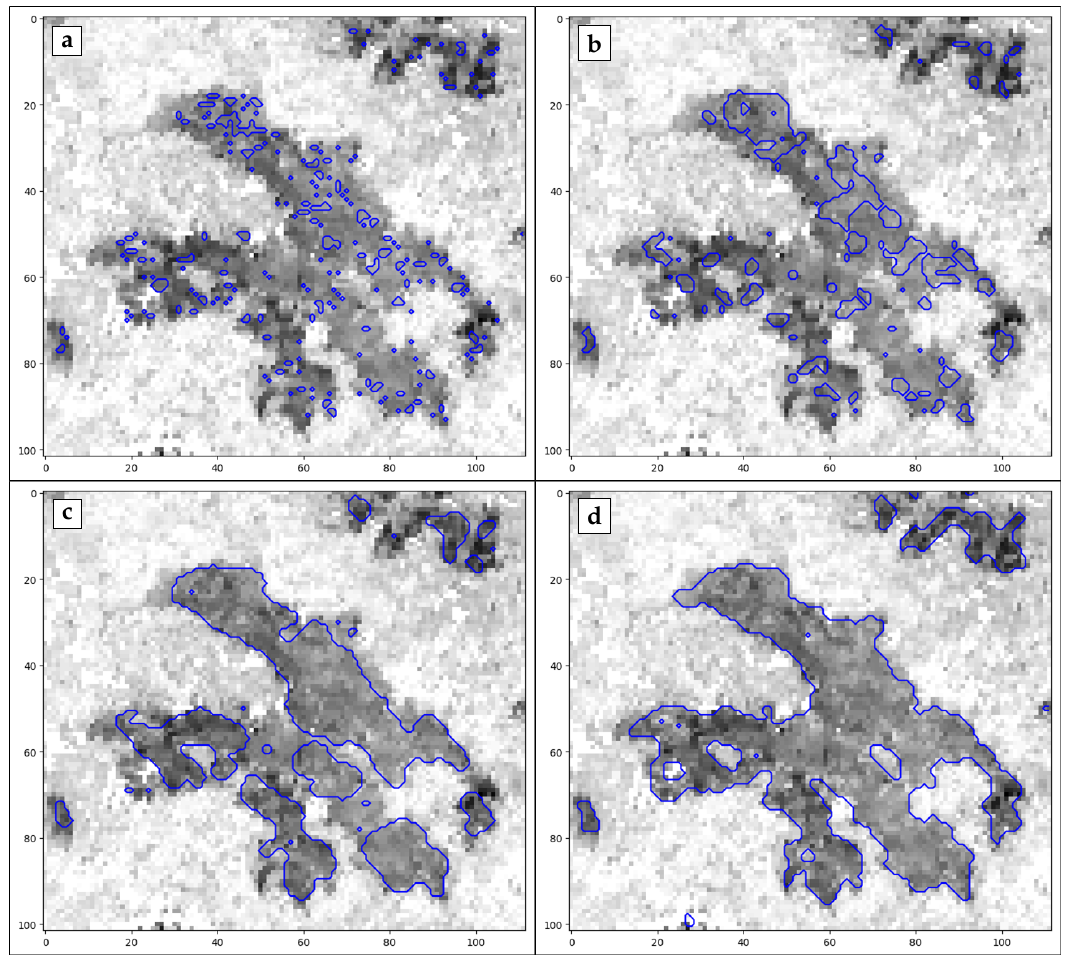
Figure 2. Evolution of the burnt area perimeter curve using Morphological Active Contours (MorphACWE) for a fire in Northern Portugal, summer 2016. The NIR channel of a Sentinel-3 Ocean and Land Color Instrument (OLCI) post scene is used as background. ( a ) Initial state of the curve. ( b ) State after 10 iteration steps. ( c ) State after 25 iteration steps. ( d ) Final state after 50 iteration